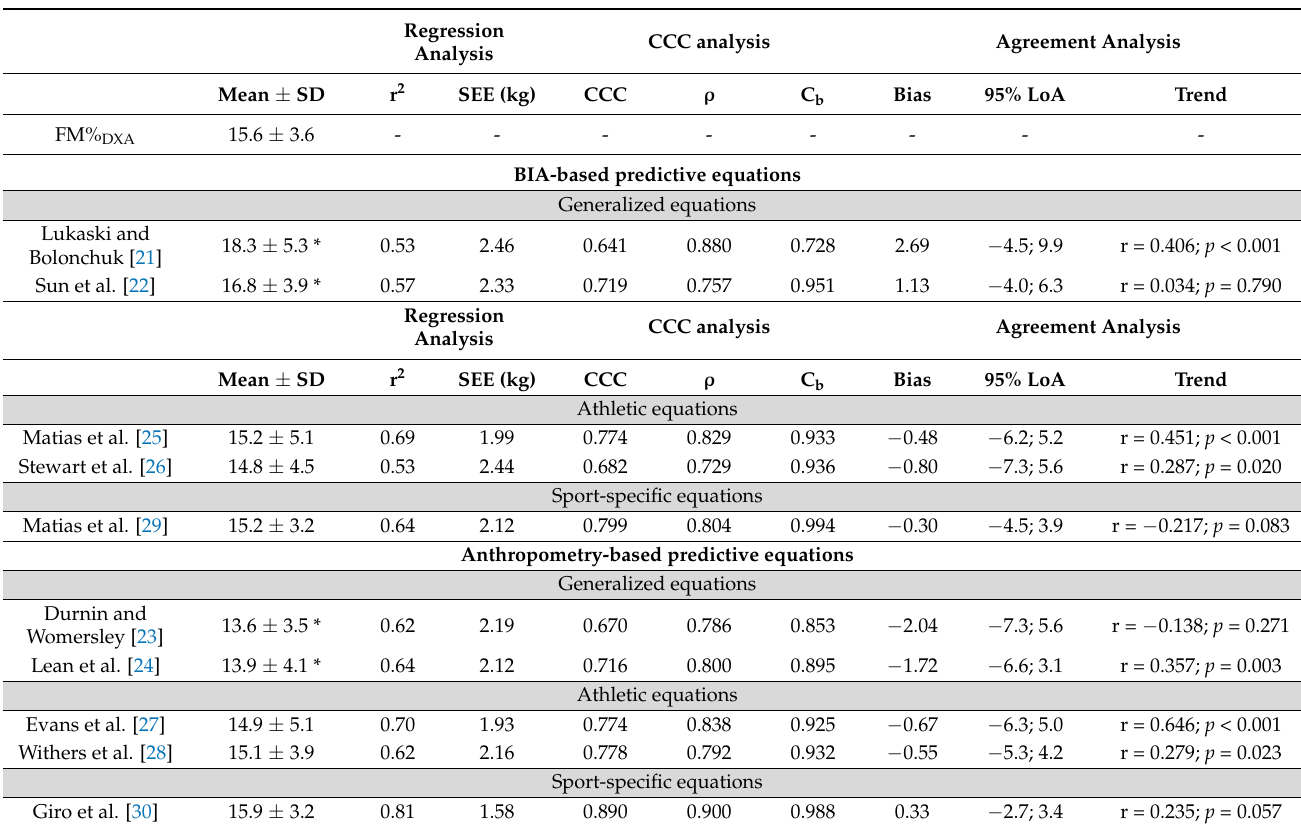
Table 2. Validation of the selected BIA- and anthropometry-based predictive equations in the futsal